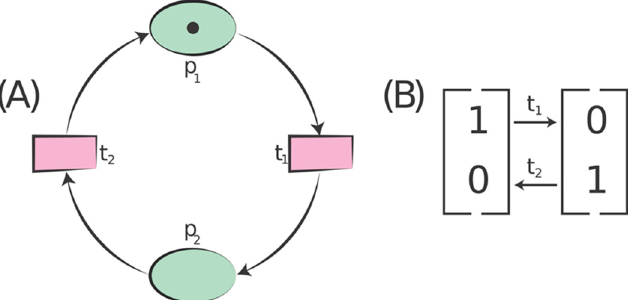
Fig 3. Example of a Standard Petri Net . (A) A Petri Net consists of a set of places { p 1 , p 2 }, set of transitions { t 1 , t 2 } and an initial marking M 0 consisting of one token in place p 1 . In this example, the weight of the arcs are not specified so every arc weighs 1. The enabling degree of a transition is determined by number of times a transition can be fired without depositing a token again to the input place of a transition through self-loop. In case of above example t 1 is 1 enabled and t 2 is 0 enabled from the initial marking M 0 . (B) The reachability graph obtained from initial marking M 0 of the Petri Net . A reachability graph consist of set of places which can be reached from M 0 and arcs which are labelled with enabled transitions. This graph shows one cycle: (1, 0) ! (0, 1) ! (1, 0) and contains no deadlock. To reach marking M 1 = (0, 1) from the marking M 0 = (1, 0), a firing sequence S consist of a transition t 1 once and transition t 2 zero time.